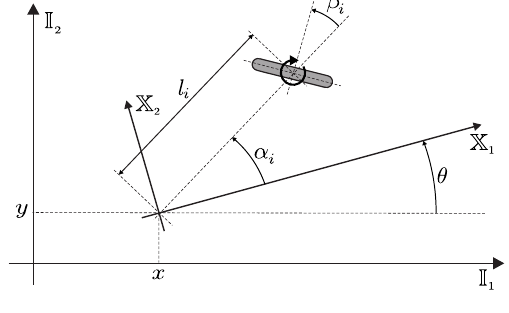
Figure 1. A center-steerable standard